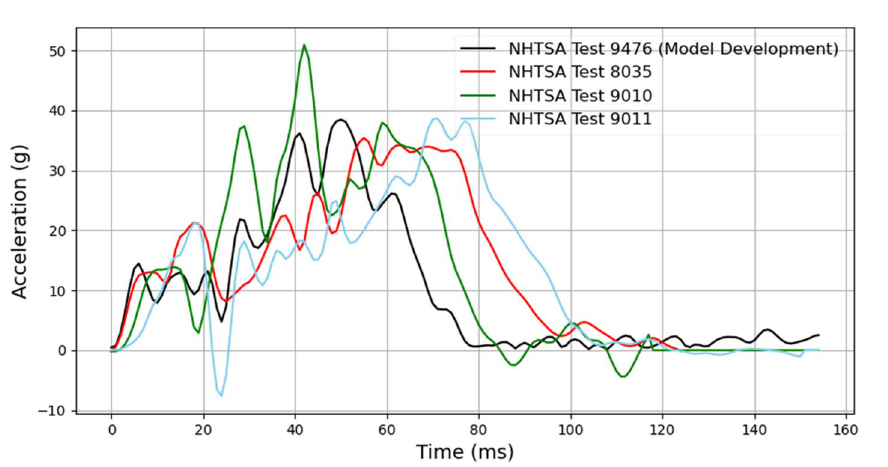
Figure 6. Crash pulses from NHTSA crash